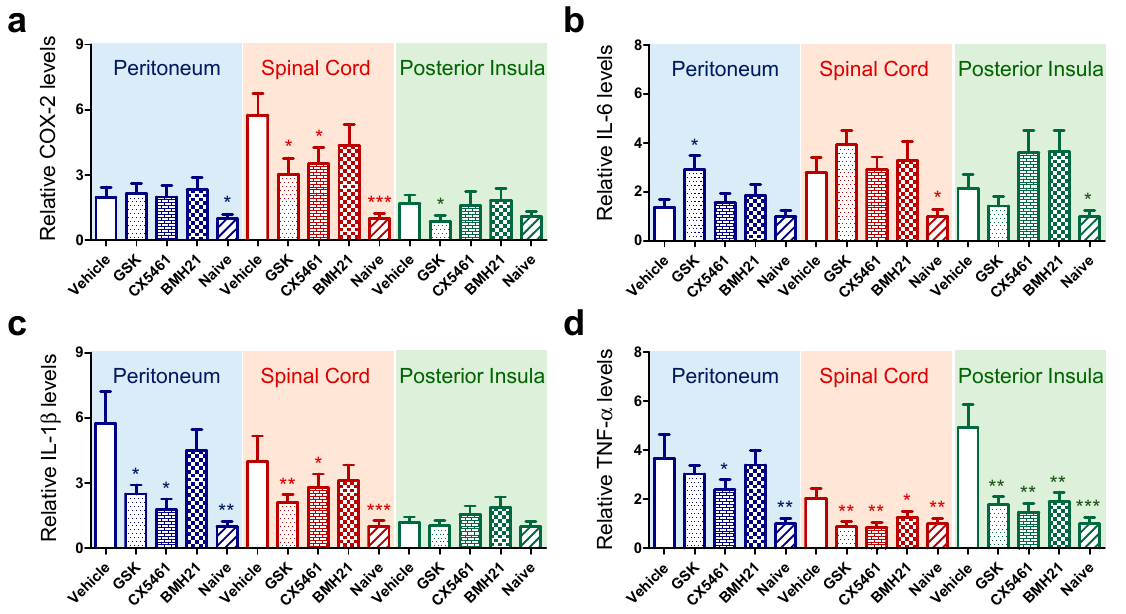
Figure 5. Expression of inflammatory mediators in peritoneal tissue, spinal cord and brain. RNA was extracted from peritoneal tissue (blue), spinal cord (red) and posterior insula (green) in the brain of experimental mice and subjected to cDNA synthesis. qPCR was performed on cDNA samples ( n = 6 for each group) to detect the expression levels of inflammatory mediators, including ( a ) COX-2, ( b ) IL-6, ( c ) IL-1 β and ( d ) TNF- α in different tissues (Table S2). The data were normalized with the average levels in naïve mice. Statistical differences between vehicle and drug-treated groups were compared by using t -test. The p values were presented as *: p value < 0.05, **: p value < 0.01 and ***: p value < 0.001.